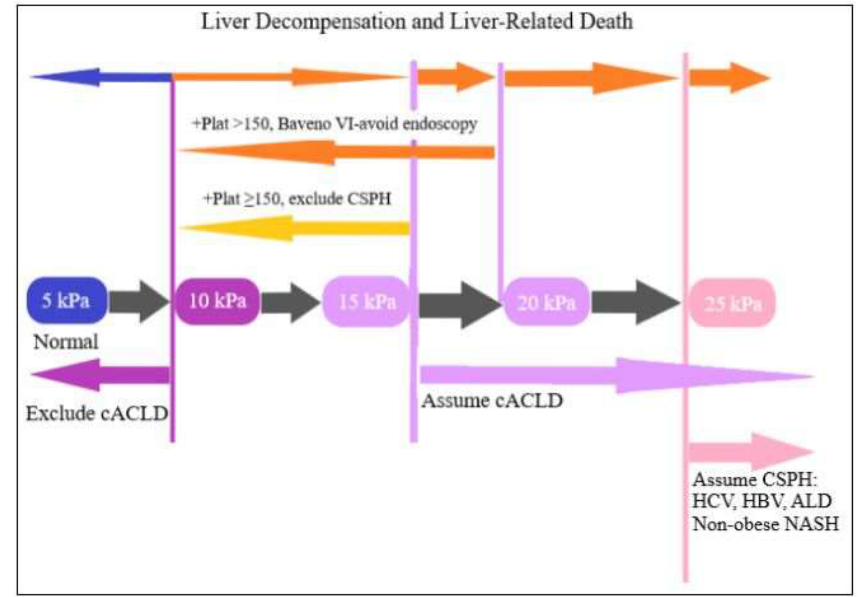
Figure 1. Representation of Baveno VII criteria.